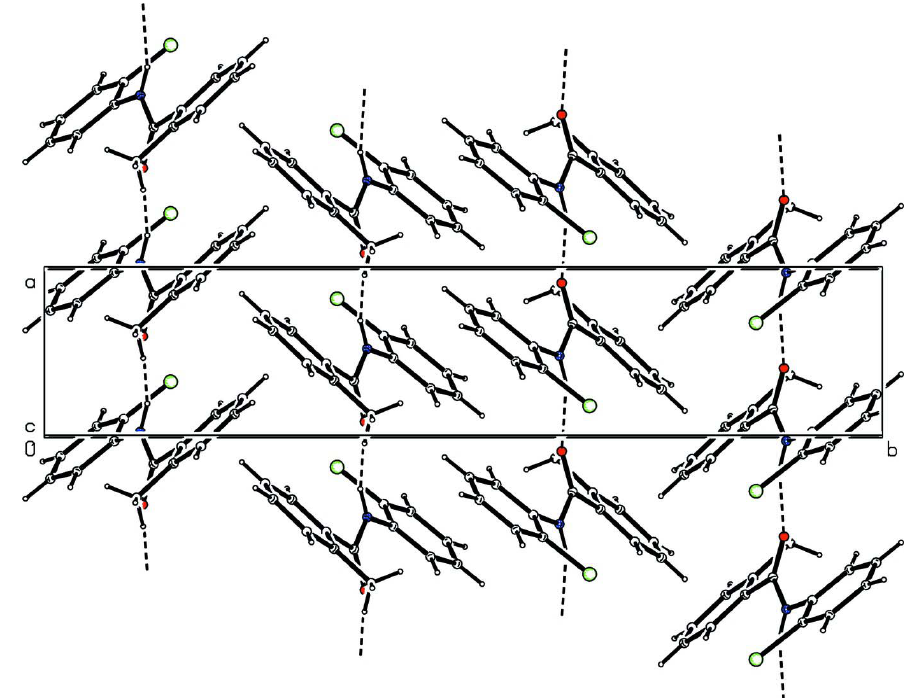
Figure 2 Molecular packing of the title compound with hydrogen bonding shown as dashed